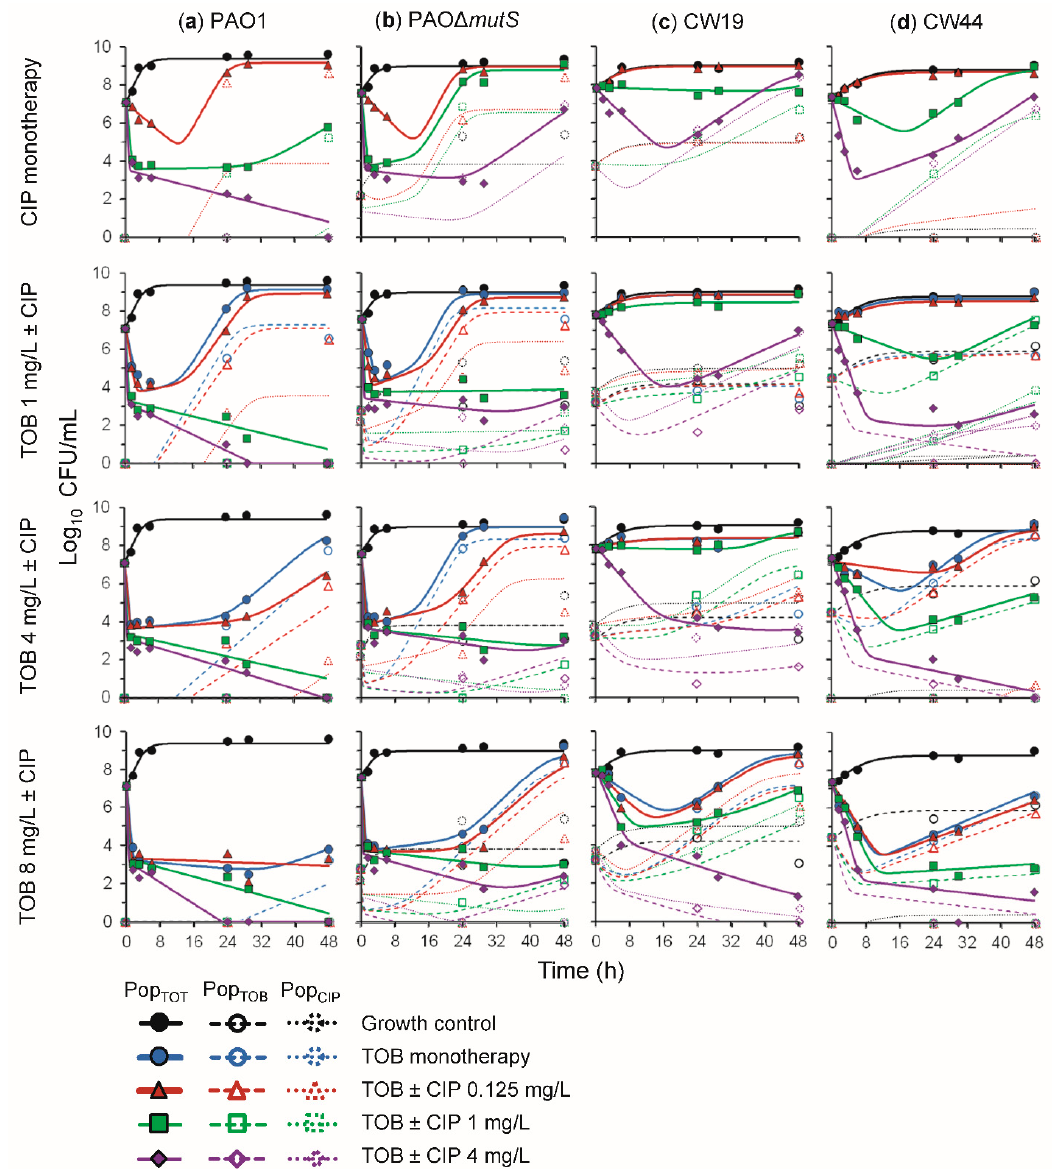
Figure 4. The log 10 viability counts (CFU/mL) of bacterial growth versus time for ( a ) non-hypermutable PAO1, ( b ) hypermutable PAO ∆ mutS , ( c ) CW19, and ( d ) CW44 exposed to tobramycin (TOB) and ciprofloxacin (CIP) alone and combined in 48-h static concentration time-kill experiments at an inoculum of ~10 7.5 CFU/mL. The top-tier panels show the growth control and ciprofloxacin monotherapies, the second-tier panels show the 1 mg/L tobramycin in monotherapy and combinations with ciprofloxacin, the third-tier panels show the 4 mg/L tobramycin in monotherapy and combinations with ciprofloxacin, and the fourth-tier panels show the 8 mg/L tobramycin in monotherapy and combinations with ciprofloxacin. The solid lines and symbols represent the total population (Pop TOT ) on drug-free agar plates and the hollow symbols with dashed and dotted lines are the tobramycin- (Pop TOB ) and ciprofloxacin-less susceptible (Pop CIP ) populations, respectively. All lines are mechanism-based model fits.